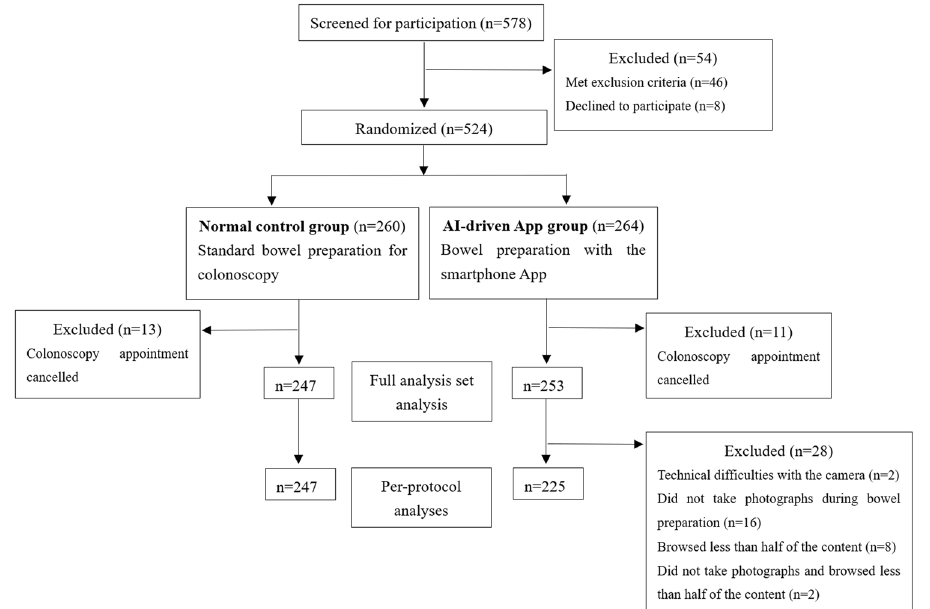
Fig. 1 Flowchart of the clinical trial. AI arti fi cial intelligence, App